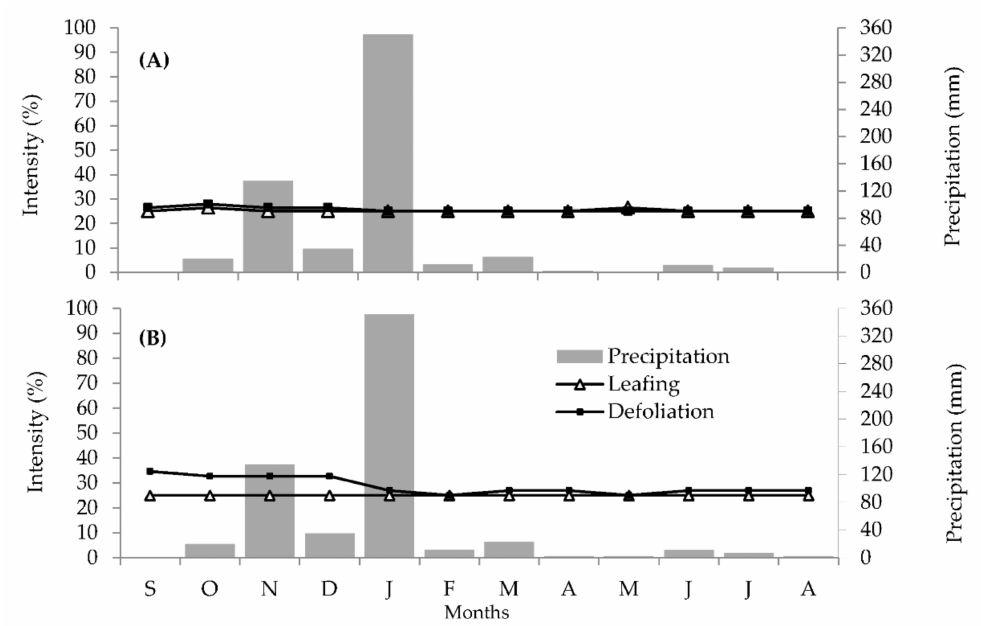
Figure 1. Fournier intensity of the vegetative phenology of Diospyros sericea and climatic variables in the area surrounding the Serra Nova e Talhado State Park (PESNT), district of Rio Pardo de Minas, Minas Gerais state, Brazil. Data recorded between September 2015(S) and August 2016(A). ( A ) Male individuals. ( B ) Female